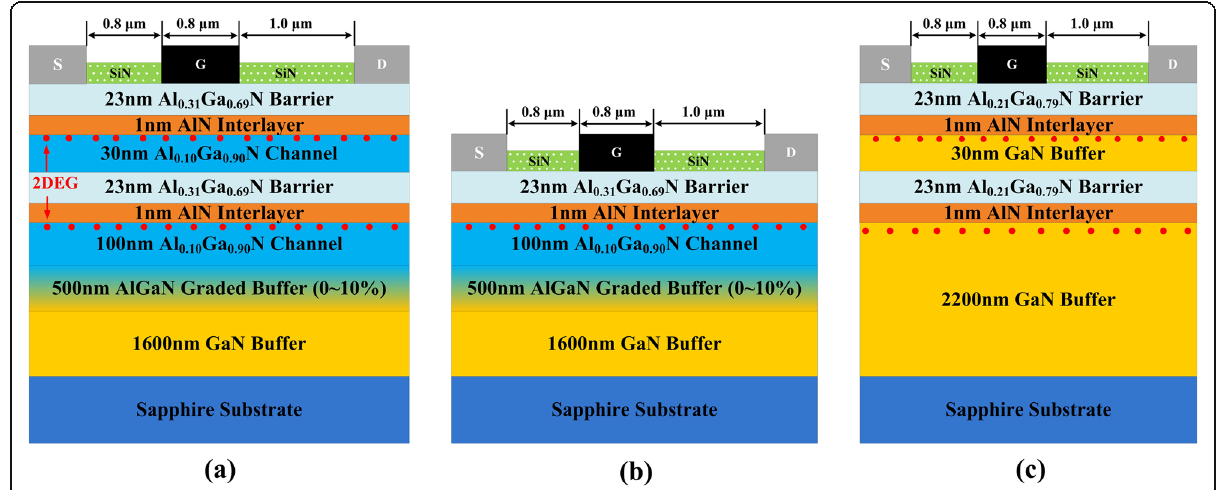
Fig. 1 Cross-sectional view (not to scale) of a AlGaN double channel, b AlGaN single channel, and c GaN double channel heterostructures